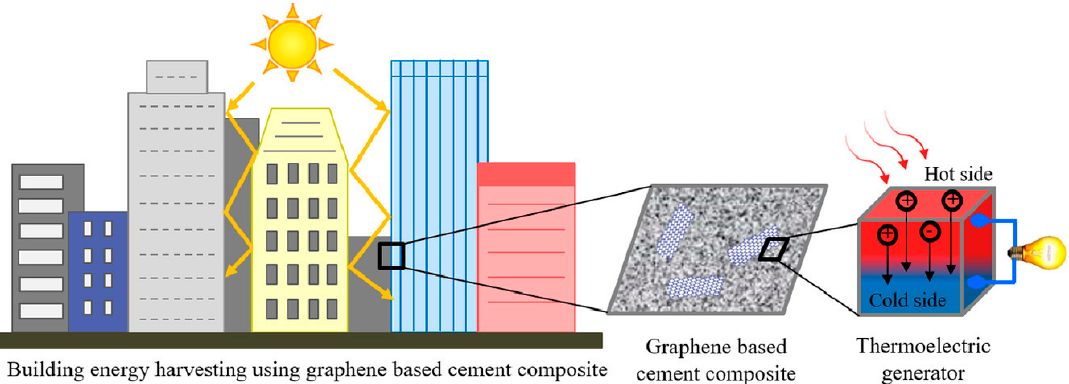
Figure 23. Building energy harvesting using thermoelectric generator of graphene cement composite. Reproduced with permission from [164], Elsevier, 2019.